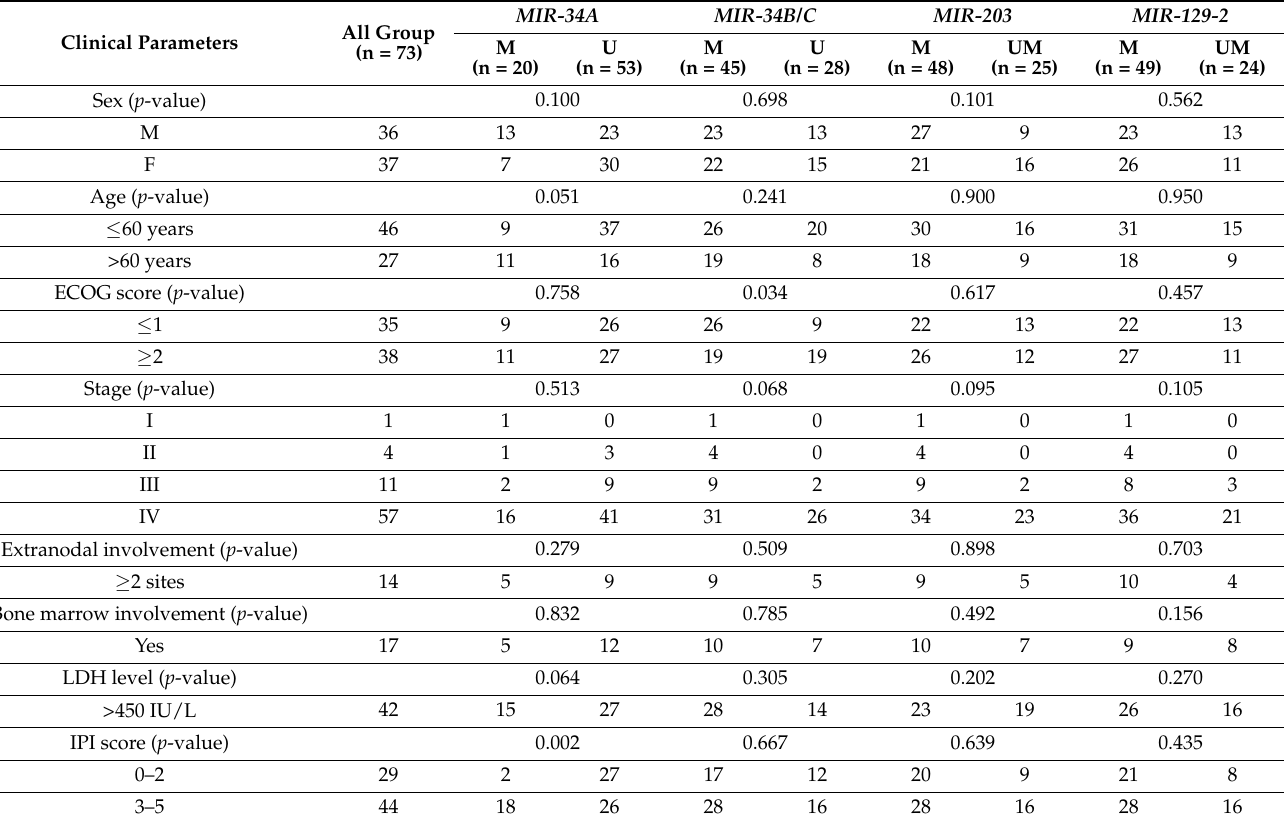
Table 3. Clinical parameters of the DLBCL patients of the study